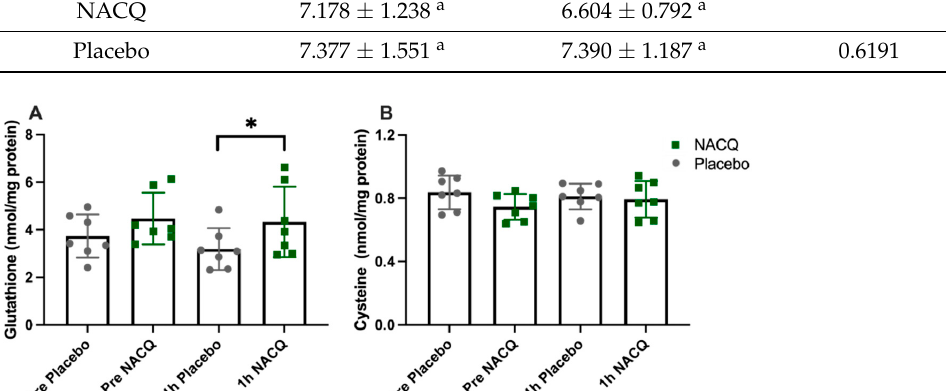
0.99) (Table 3, Figure 3B).